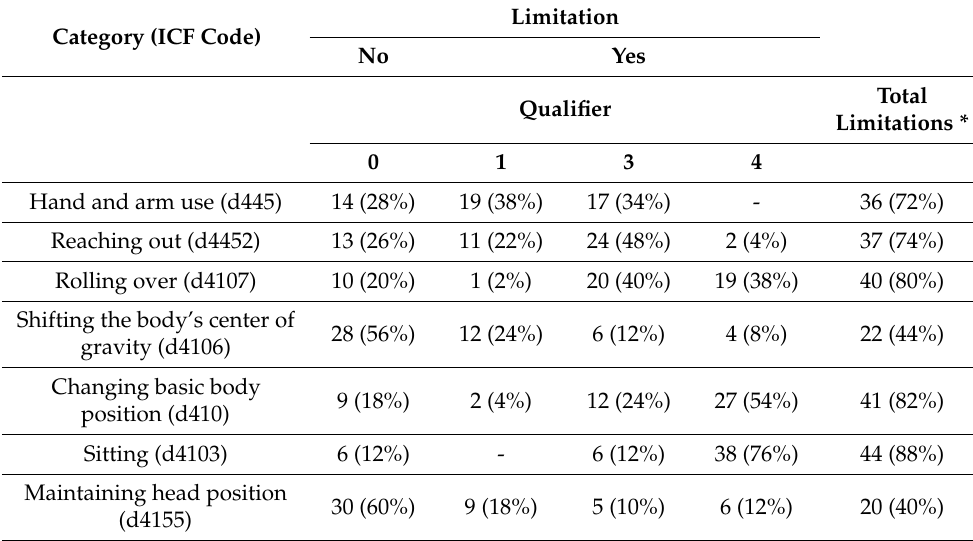
Table 3. Characterization of limitations observed in preschool aged children with CZS (n =